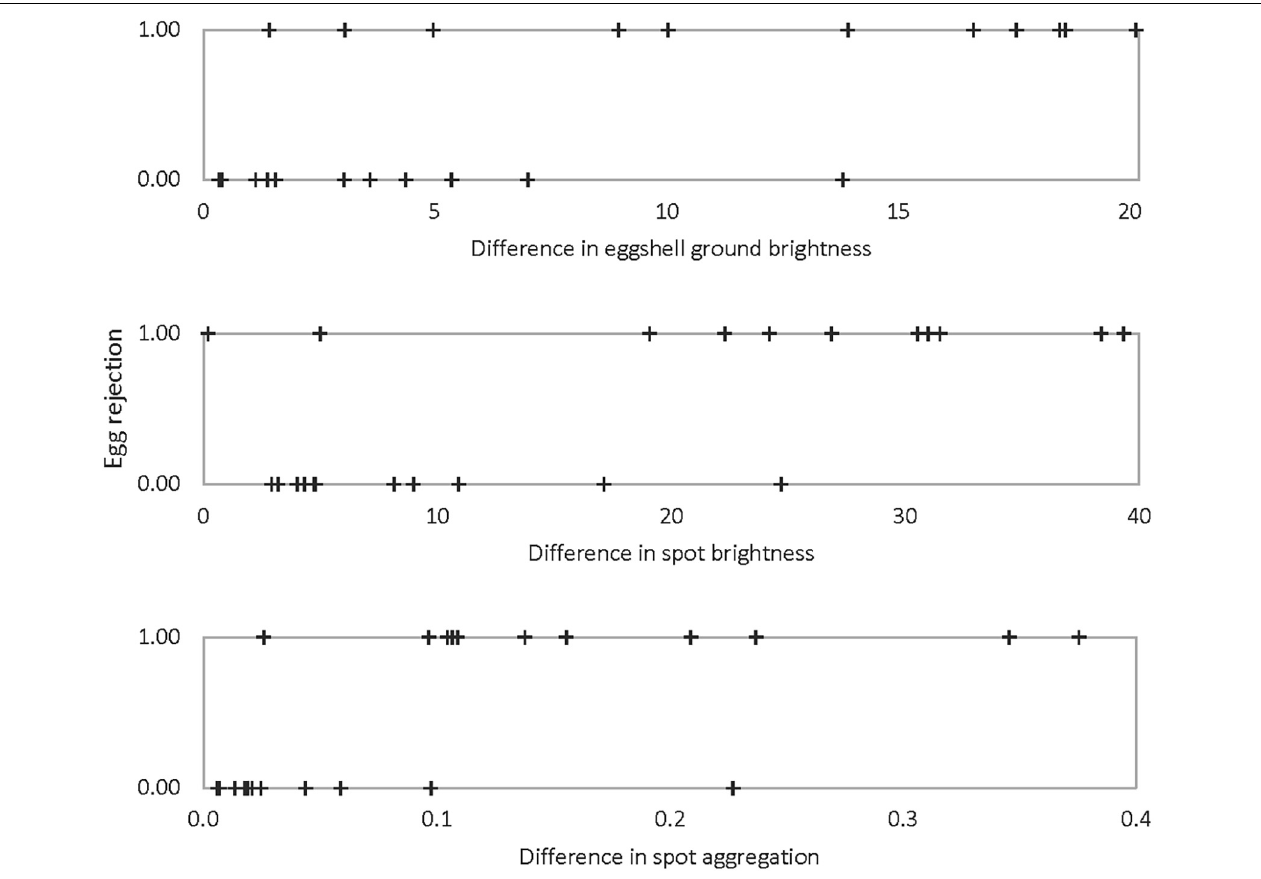
FIGURE 6 | Egg rejection by Rüppell’s weaver in relation to the difference between own and foreign eggs in three variables: eggshell ground brightness (mean% reflectance across the UV-VIS spectrum), spot brightness (8-bit grayscale, 0–255), and degree of spot aggregation near the broad pole of the egg (0–1). Each of these three variables yielded significant single logistic regression models predicting egg rejection ( ρ 2 = 0.32–0.33, P =